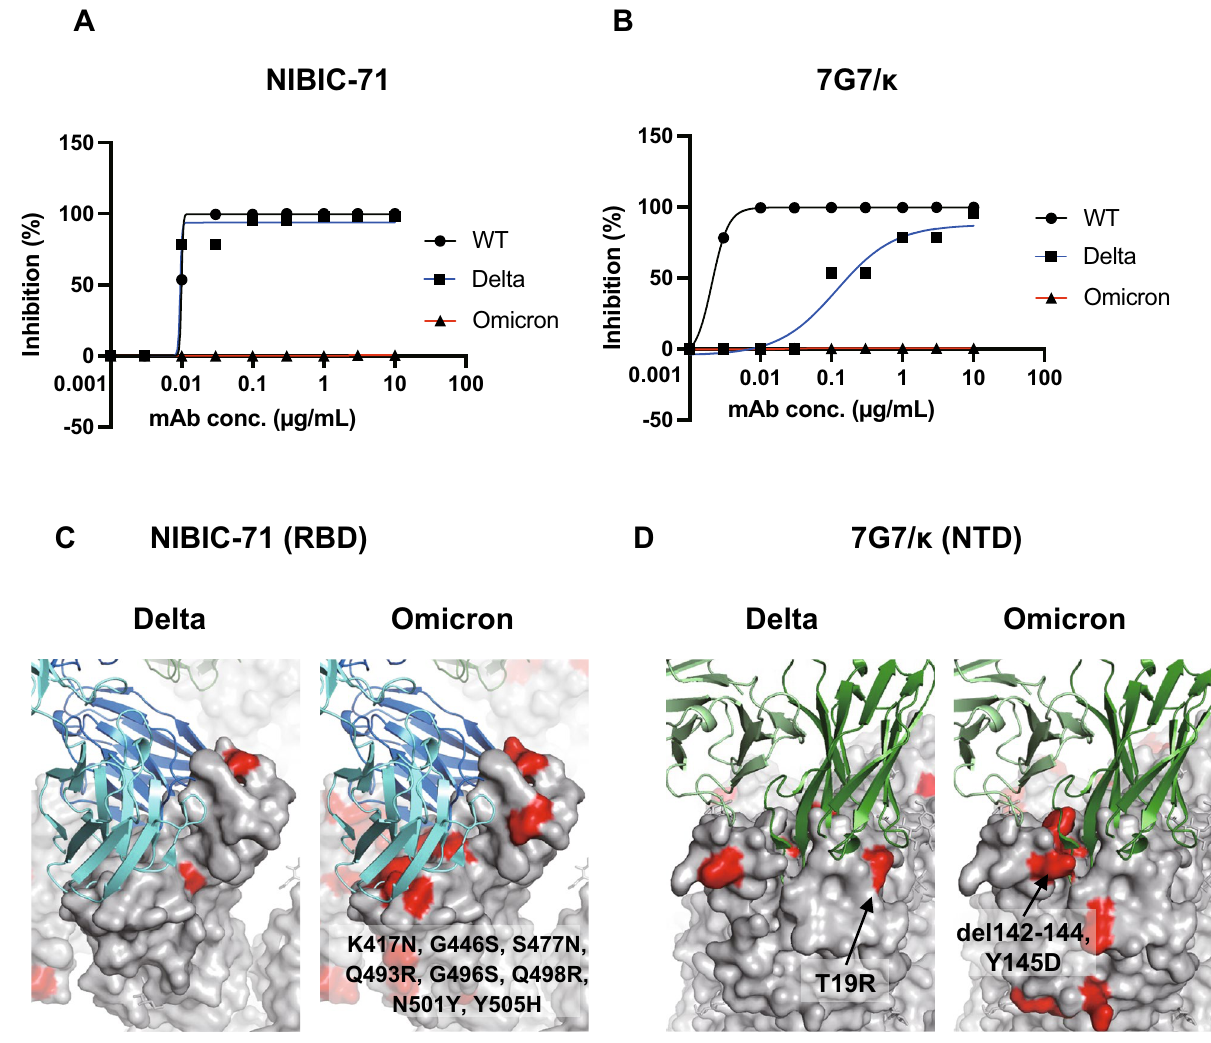
Figure 5. Evaluation of in vitro neutralizing activity against the Delta and Omicron variants. ( A ) and ( B ) VeroE6-TMPRSS2 cells were infected with WT SARS-CoV-2, Delta, and Omicron with or without serially diluted NIBIC-71 ( A ) and 7G7/κ ( B ) from 10 to 0.001 µg/mL in quadruplicate. The number of wells with CPE was counted. Viral loads were presented as TCID50s. Inhibition efficiency (%) was calculated relative to values derived from the negative control samples without any mAbs. ( C ) and ( D ) Binding region of NIBIC-71 ( C ) and 7G7/κ ( D ). Homology models of the two Fabs are generated and manually fitted into the cryo-EM maps. Surfaces of the S proteins are shown in gray, and the mutation points in Delta B.1.617.2 (left panels) or Omicron BA.1 lineage (right panels) are shown in